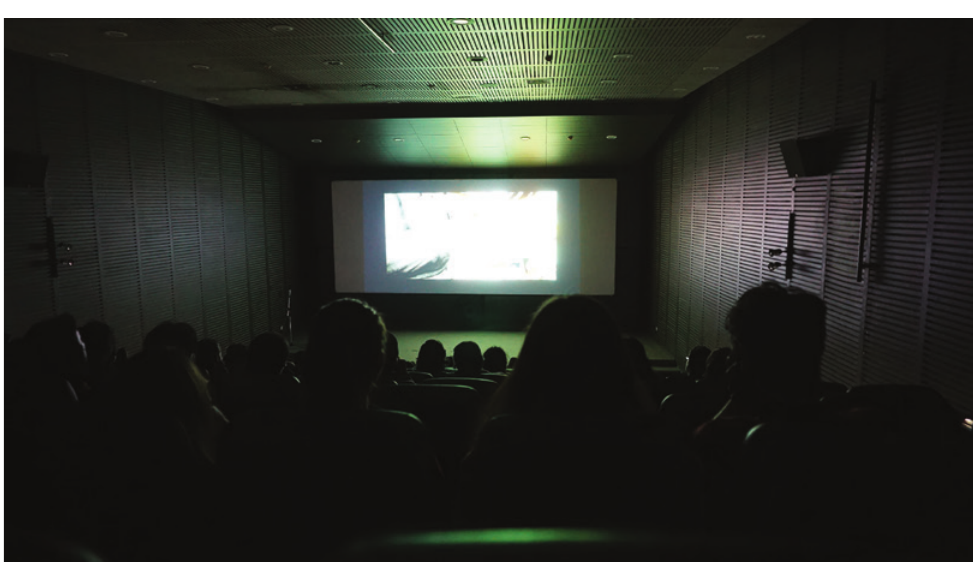
Figure 9: Premiere in the movie theatre of Cineteca Nacional de Chile with the participating schools in the programme Cine en curso Chile. After the screening of the documentary, the Colegio Alicura school group read the text about their creative process and then the public asked questions and made comments (for the full movie and the presentation by Colegio Alicura, see: https://vimeo. com/115092532 and